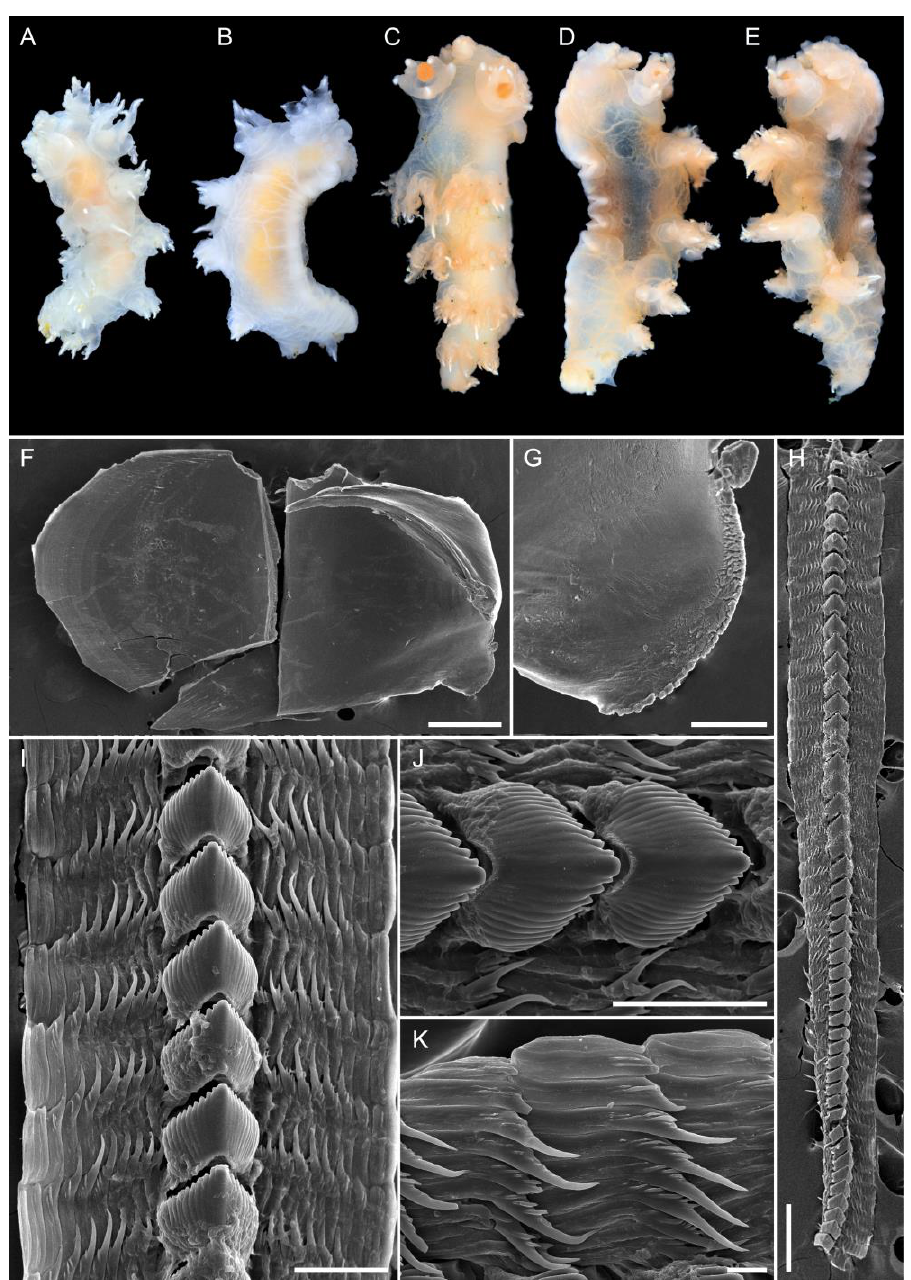
Figure 5. Dendronotus pseudodalli sp. nov., features of external and internal morphology (SEM). ( A , B )—holotype MIMB44619, dorsal view ( A ) and lateral view from the right ( B ). ( C – E )—paratype MIMB44620, dorsal view ( C ), lateral view from the left ( D ) and right ( I ). ( F ) – paratype MIMB44620, left jaw plate. ( G ) — paratype MIMB44620, masticatory process of the jaw. ( H ) — paratype MIMB44620, radula. ( I ) — paratype MIMB44620, middle radular portion. ( J ) — paratype MIMB44620, rachidian teeth. ( K ) — paratype MIMB44620, lateral teeth. Scale bars: ( F ) = 500 µm; ( G , I , K ) = 100 µm; ( H ) = 300 µm; ( J ) = 20 µm.